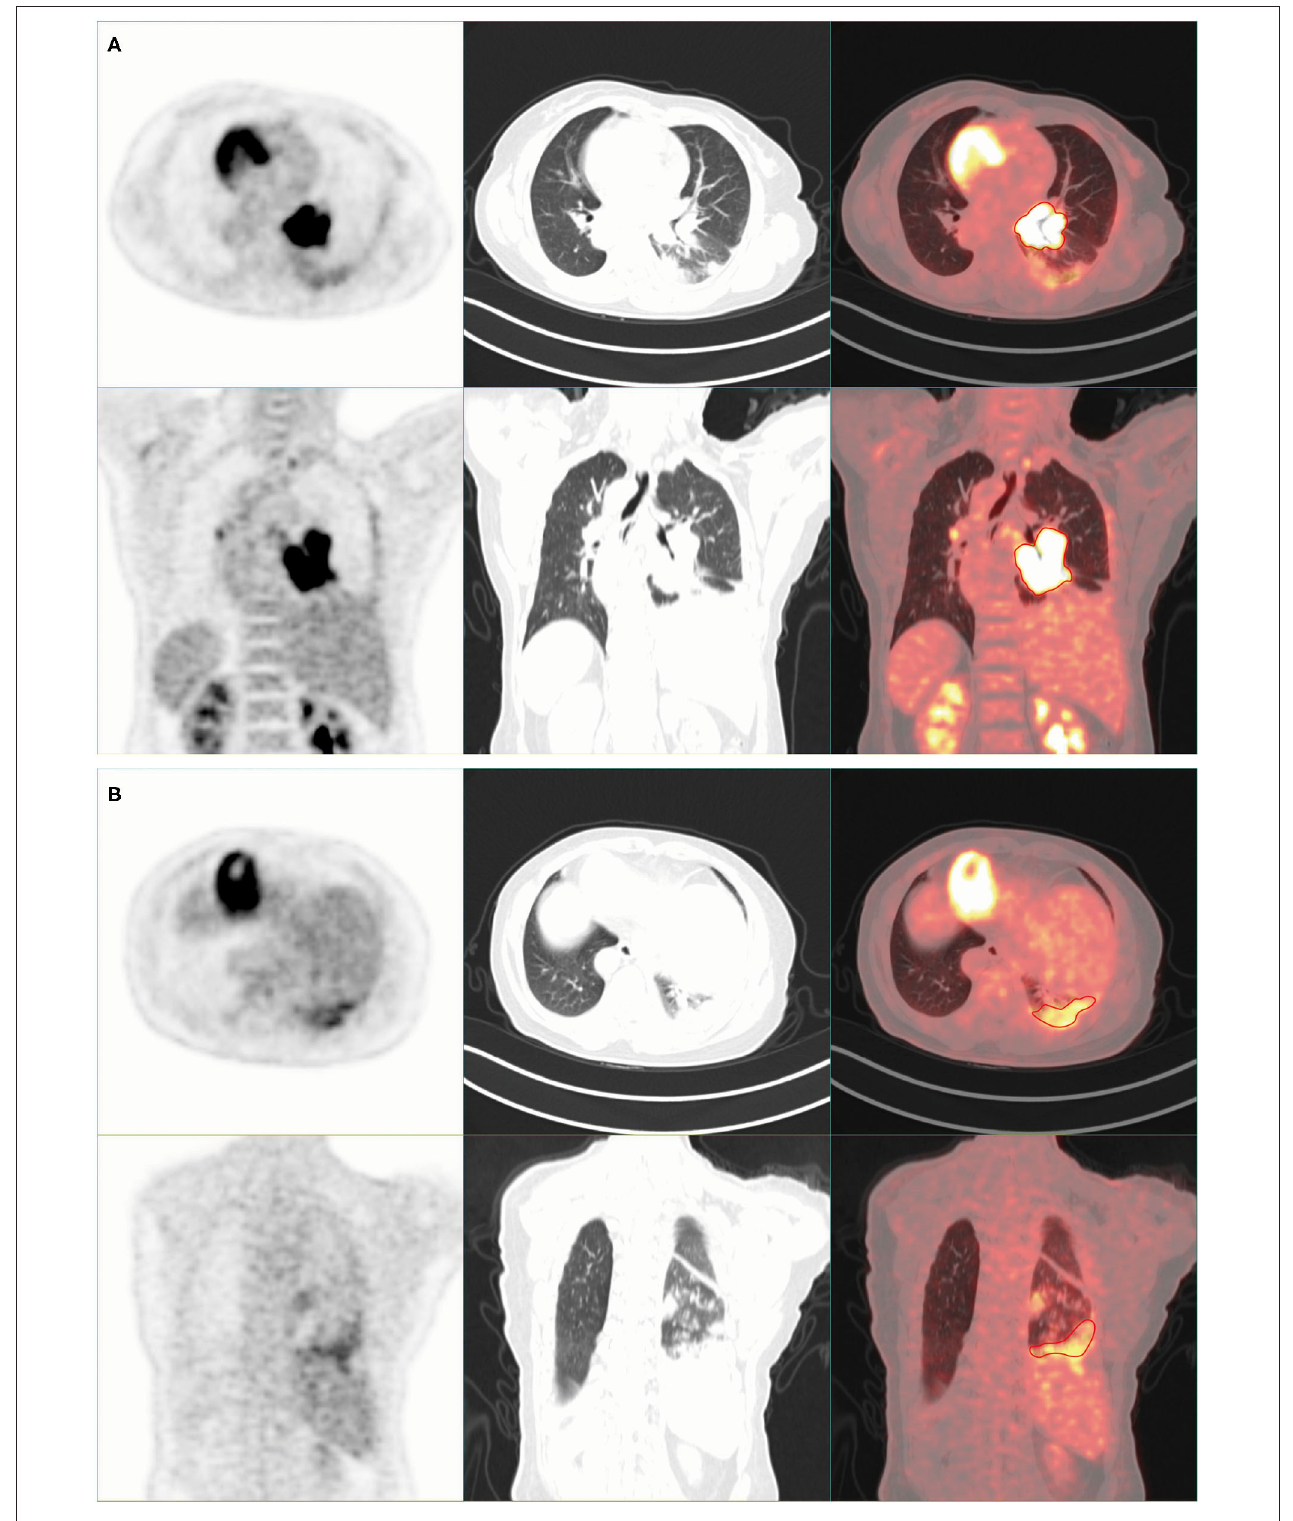
FIGURE 1 | Chest imaging of positron emission tomography (PET)/CT scan. (A) There was high tracer uptake in the left hilar area. (B) The bronchus of the lower lobe of the left lung was truncated, and high tracer uptake was observed.